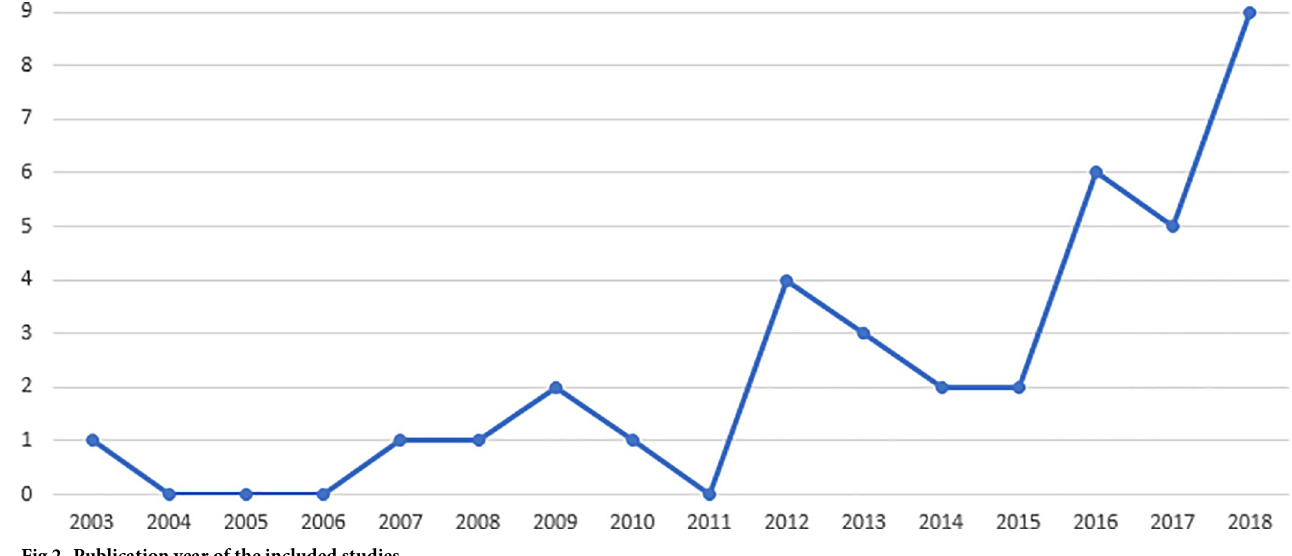
Fig 2. Publication year of the included studies.